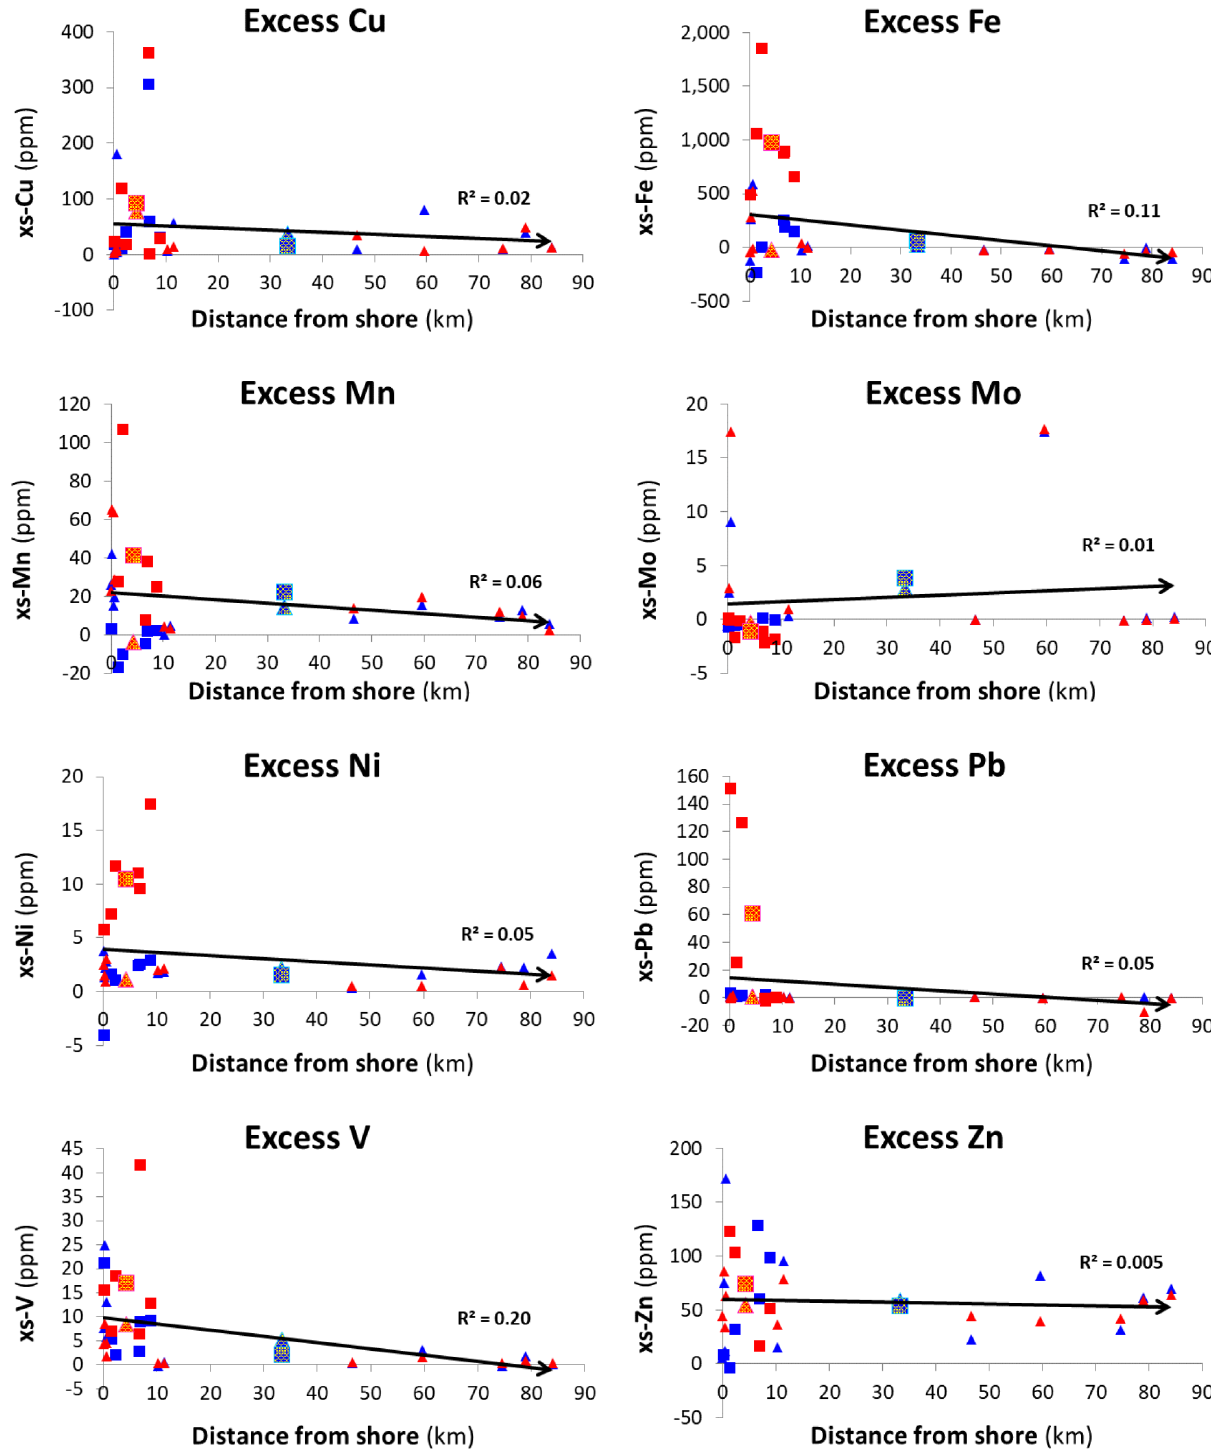
Figure 7. The excess concentrations of each element in alphabetical order after lithogenic correction using average Qatari dust versus the shortest distance from the sampling site to land. The graphs show the combined data from four data sets: 50 and 200µm mesh net tows for both 2012 and